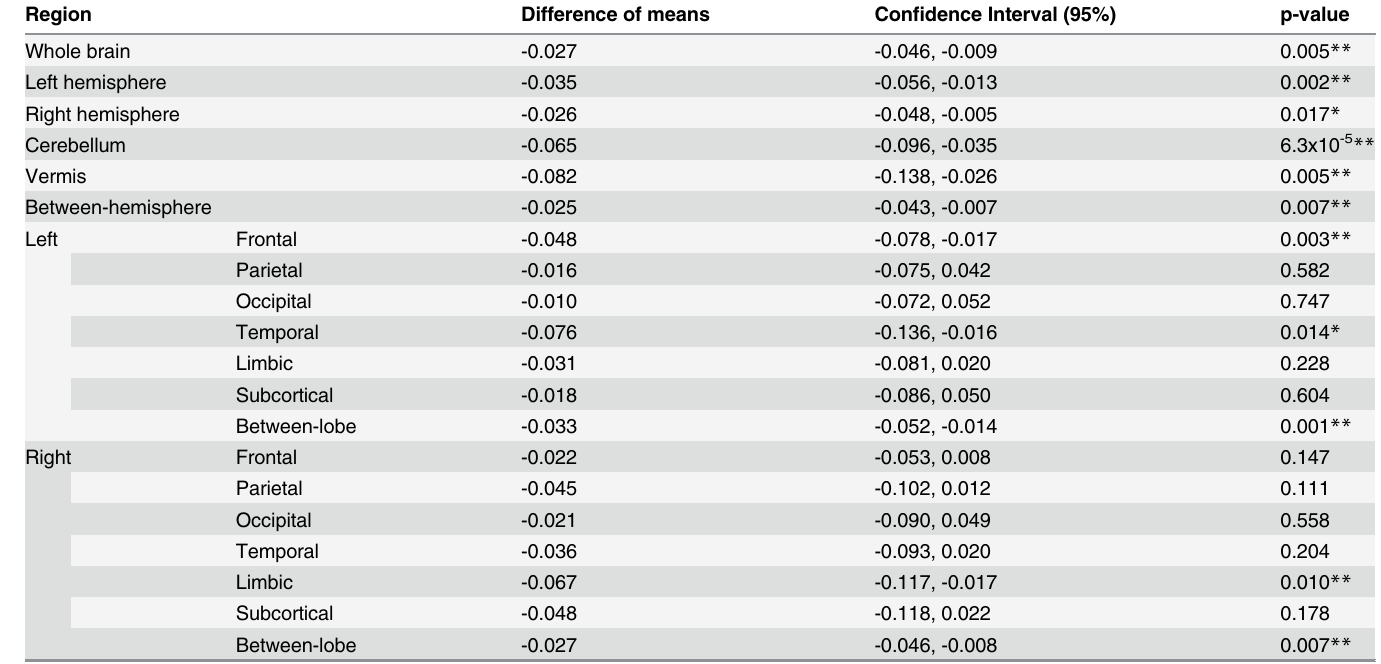
Table 4. Semi-metric percentages for MDD vs control